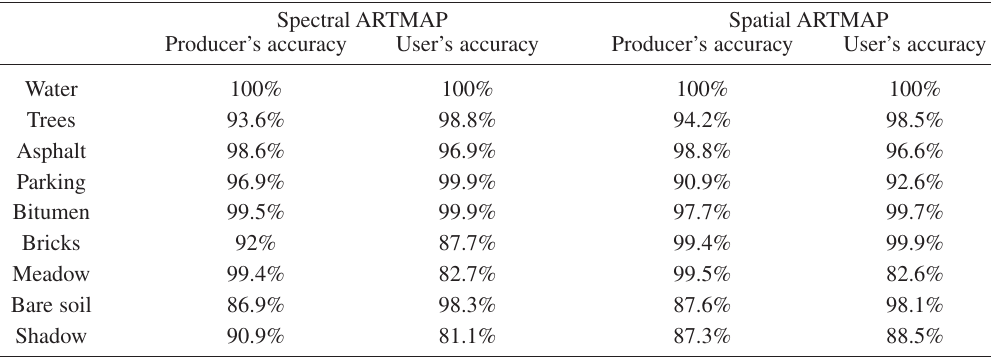
Table I. Accuracy values for ARTMAP applied to the test area in fig.